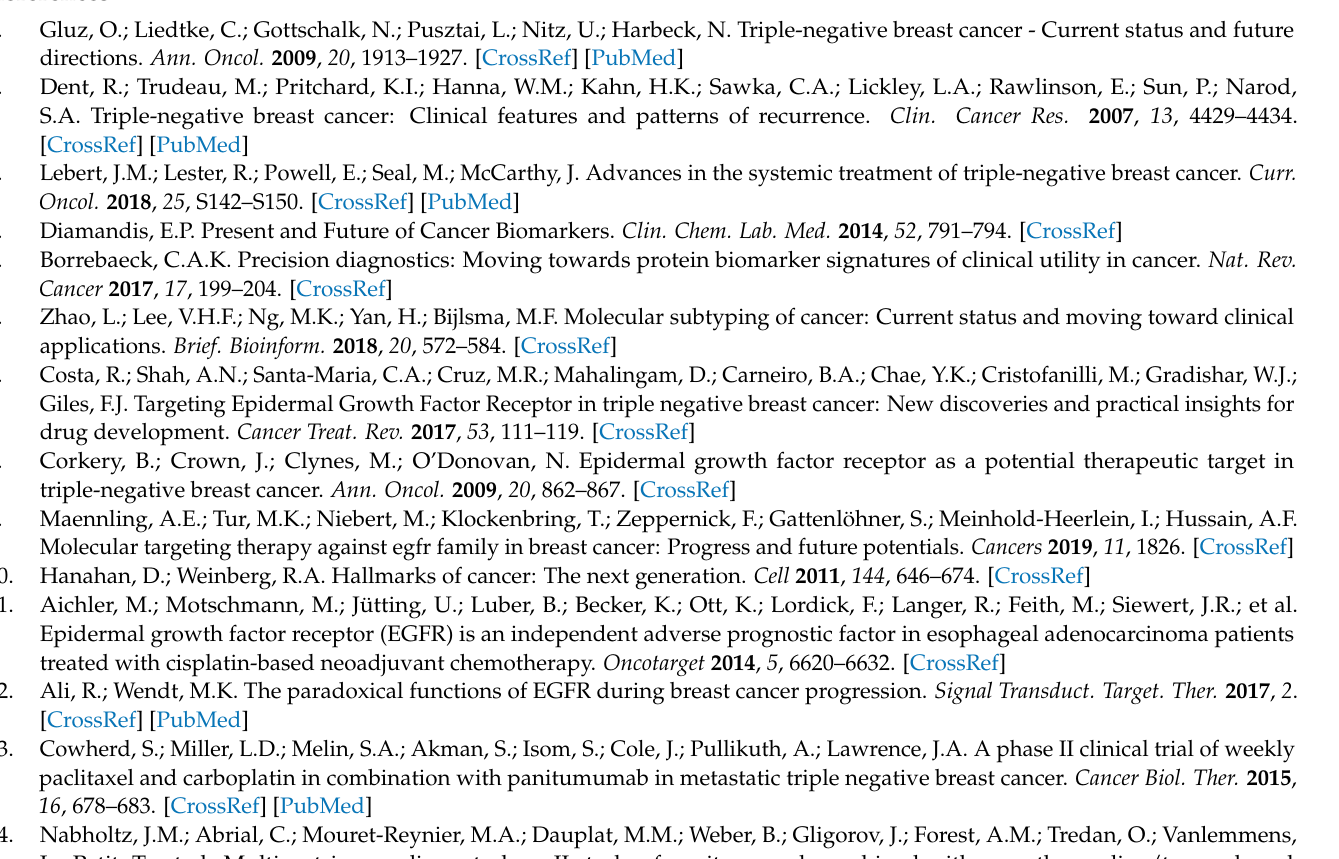
day 3 and 7 in Figure 3E, Figure S6: Original western blot for pEGFR for day 21 in Figure 3E, Figure S7: Original western blot for pIGFR in Figure 3E, Figure S8: Original western blot for pAKT in Figure 3E, Figure S9: Original western blot for pS6 in Figure 3E, Figure S10: Original western blot for pERK in Figure 3E, Figure S11: Original western blot for GAPDH in Figure 3E, Figure S12: Original western blot for pEGFR in Figure 3F, Figure S13: Original western blot for pAKT in Figure 3F, Figure S14: Original western blot for pS6 in Figure 3F, Figure S15: Original western blot for pS6 in Figure 3F, Figure S16: Original western blot for GAPDH in Figure 3F, Table S1: Metadata presenting the results of PaSSS-analysis. Reference [18] is cited in the supplementary